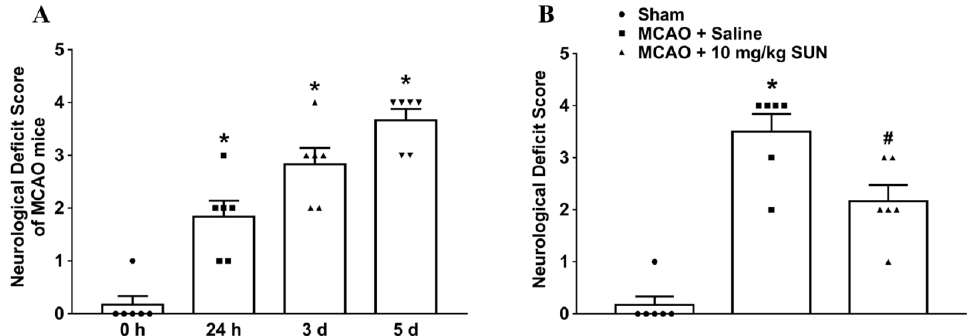
Figure 3. Time course of behavioral deficits after MCAO surgery. ( A ) Neurobehavioral deficit score was adopted to evaluate MCAO-induced cerebral damage. ( B ) Intravenous, twice-daily in- jections of DAAO inhibitor SUN (10 mg/kg) for 5 days notably inhibited behavioral deficits on day 5 after MCAO onset. Data are expressed as means ± SEM ( n = 6). * denotes statistical significance ( p <